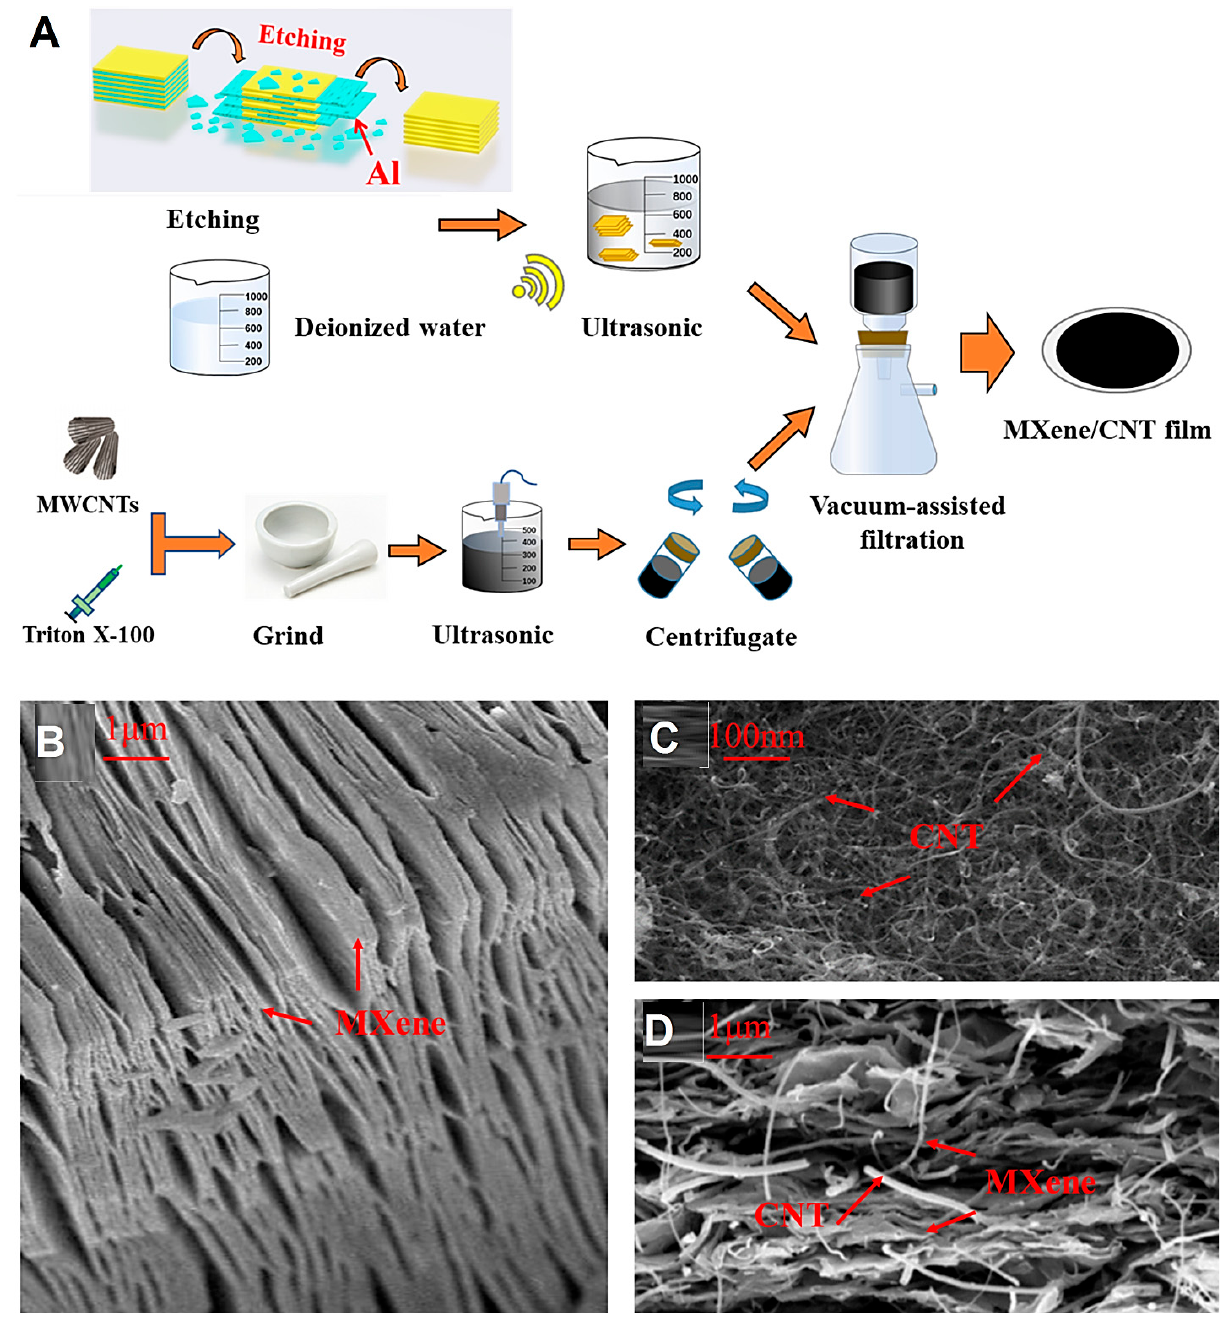
Figure 3. ( A ) The preparative process of sandwich-like MXene/CNT films. ( B ) Scanning electron microscopy (SEM) images (cross-section) of pure MXene (Ti 3 C 2 T x ). ( C ) SEM of CNTs. ( D ) SEM of MXene/CNT film (cross-section). Adapted from Ref [88] with permission. Copyright 2021 Elsevier.